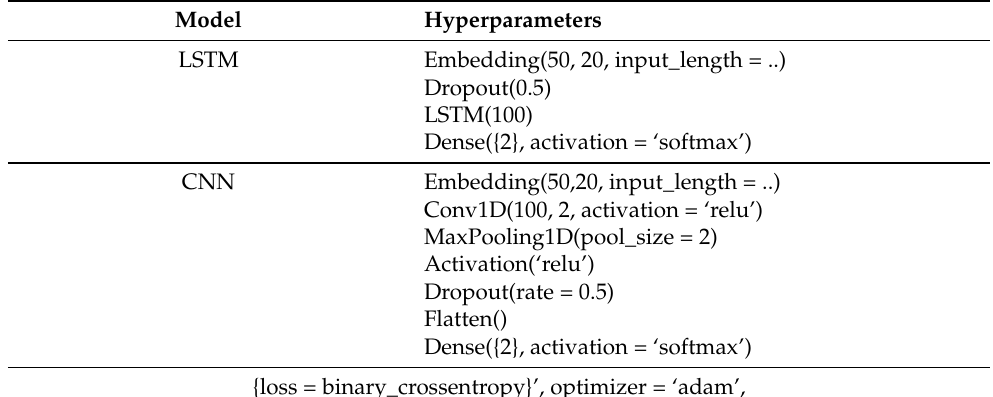
Table 6. Architecture of deep learning